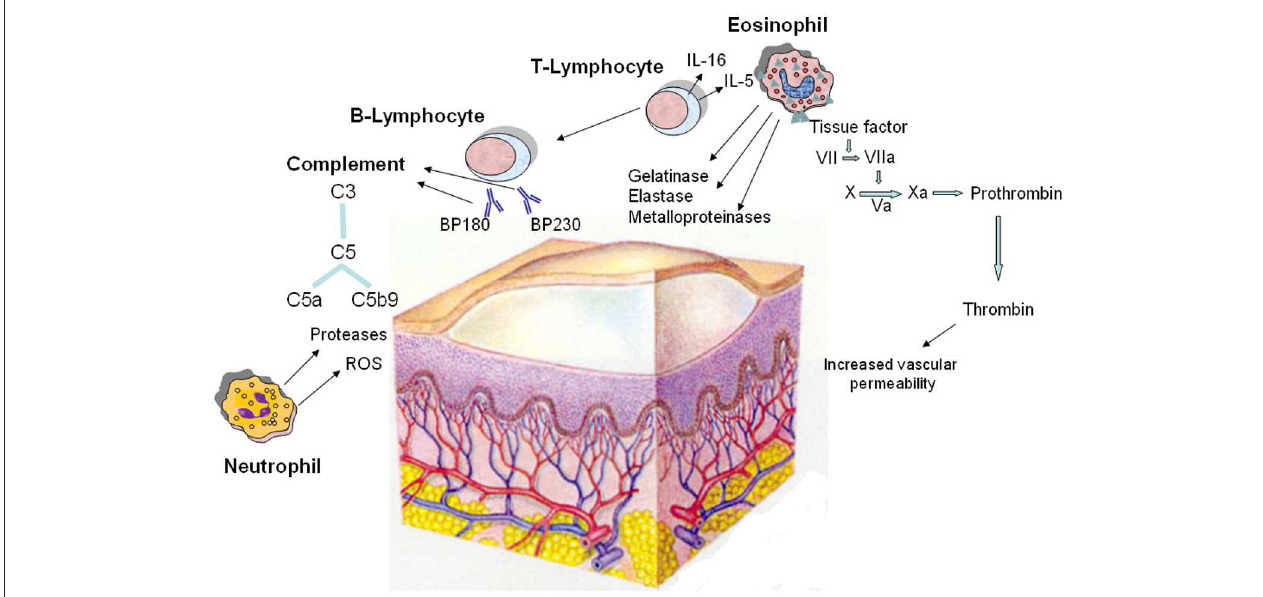
FIGURE 2 | Pathomechanisms of the blister formation in bullous pemphigoid including the involvement of coagulation activation. The dermo-epidermal detachment is due to the interaction of autoantibodies with two hemidesmosomal antigens (BP180 and BP230), followed by complement activation and leukocyte infiltration. Autoreactive T lymphocytes cooperate with B lymphocytes in the autoantibody production; in addition, they release cytokines, most notably IL-5 and IL-16, and other soluble factors responsible for the recruitment and activation of eosinophils. In lesional skin, eosinophils produce and release metalloproteinases, elastase, and gelatinase which contribute to tissue damage. Moreover, eosinophils strongly express tissue factor, which is the main initiator of the coagulation cascade (factors VII, X, VIII, V, and prothrombin) leading to generation of thrombin. This last increases the permeability of blood vessels, amplifying the inflammatory network. Neutrophils contribute in the pathogenesis of bullous pemphigoid by releasing reactive oxygen species (ROS) and proteases. Finally, complement is activated upon binding of the pathogenic autoantibodies to their